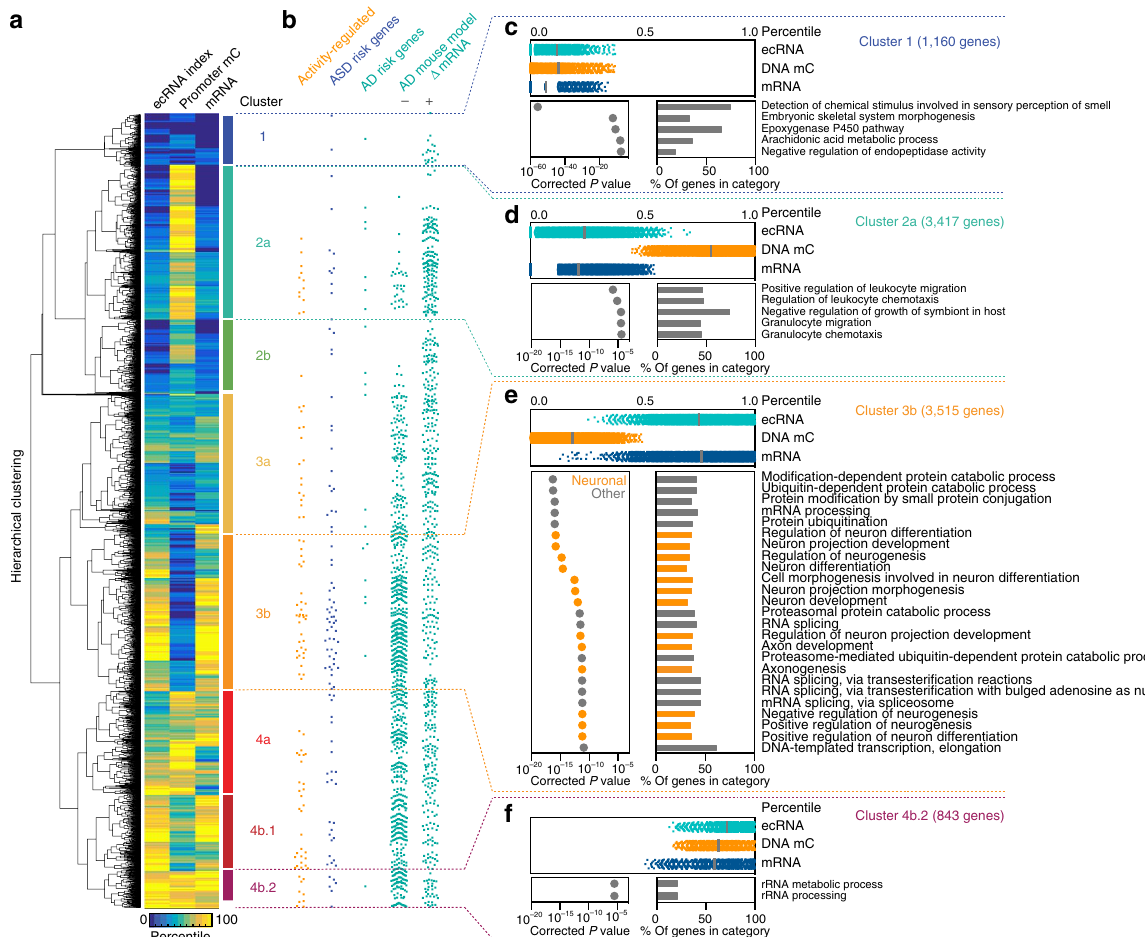
Figure 3 | High ecRNA expression is inversely related to promoter DNA methylation at genes involved in neuronal function and brain disease. ( a ) Hierarchical clustering of percentile-normalized ecRNA, DNA mC and mRNA highlights major gene clusters. Clustering was performed using percentile scores instead of raw data to equalize data range. ( b ) Overlap between distinct gene clusters and activity-responsive (Veh versus KCl genes from Fig. 2a), genes harbouring mutations associated with autism spectrum-disorders 43 (ASD risk genes), genes implicated in Alzheimer’s disease risk 44 (AD risk genes) and genes altered in an animal model of Alzhiemer’s disease 34 (AD mouse model D mRNA genes; downregulated ( (cid:2) ) and upregulated ( þ )). Each circle represents a single gene. ( c – f ) Distribution of ecRNA, DNA mC and mRNA scores (top panels) and gene ontology analysis (bottom panels) of selected clusters. Gene ontology groups are ranked by corrected P value. Cluster 3b ( e ) is enriched for genes involved in neurogenesis, neuronal projection and neuronal development. This cluster represents 19.8% of genes investigated but contains 34% of activity-regulated genes (odds ratio ¼ 1.69; P ¼ 0.0079), 40% of the genes implicated in ASD (odds ratio ¼ 2.006; P ¼ 0.0003) and 39% of genes that are downregulated in a mouse AD model (odds ratio ¼ 1.966; P o